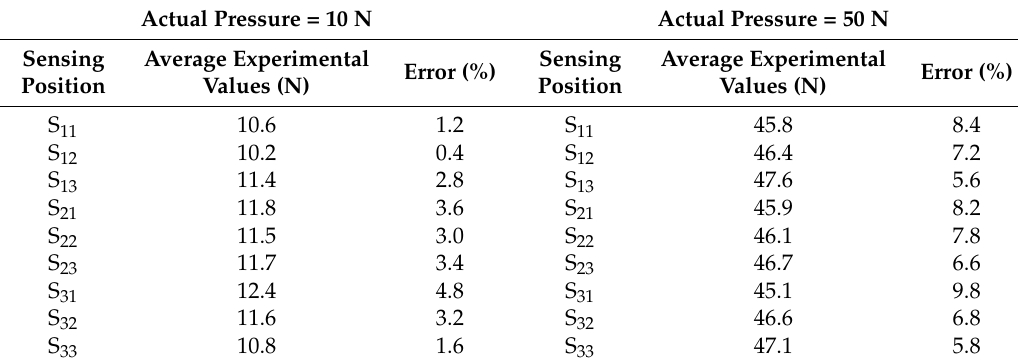
Table 1. The bias error for the sensing units in each horizontal-vertical channel are recorded.